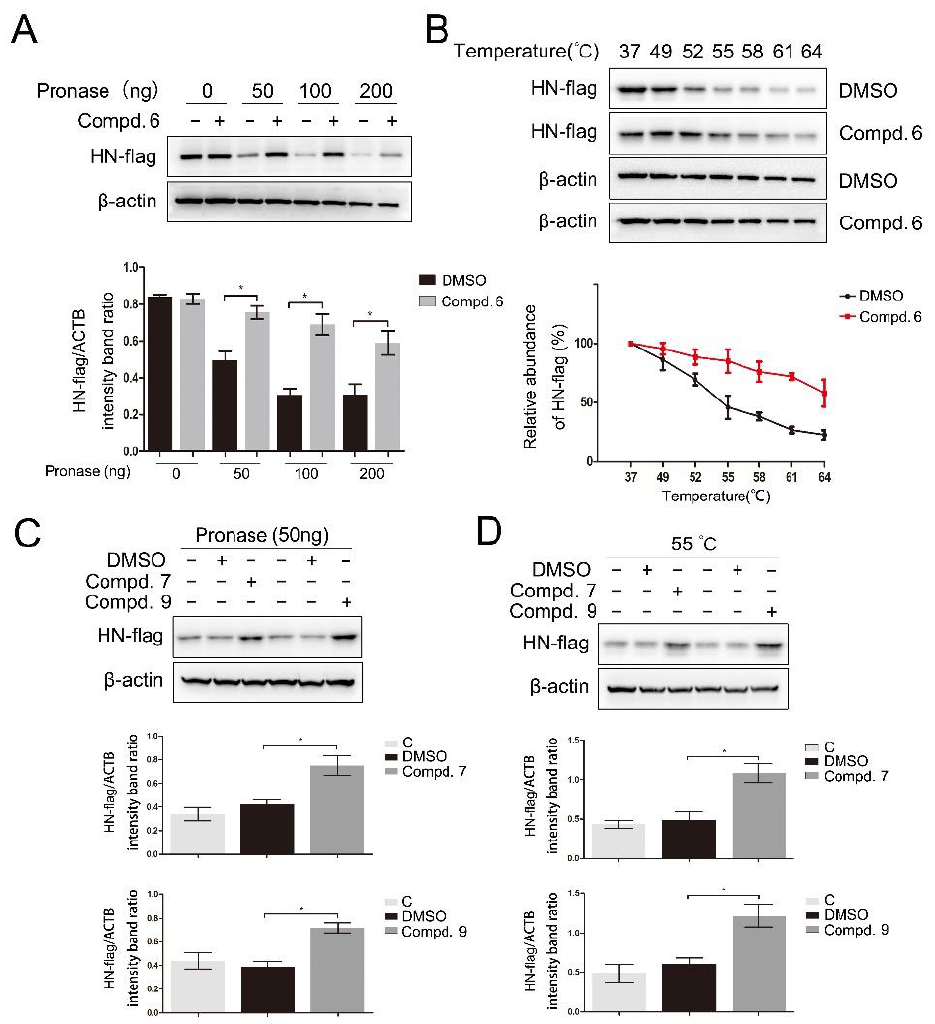
Figure 5. Direct binding of 1-formyl- β -carboline derivatives with the HN protein. DF-1 cells, transfected with the HN-flag, were lysed with M-PER lysis buffer and incubated with 1-formyl- β -carboline derivatives (200 µ M) or DMSO. ( A ) The cell lysates were treated with the indicated concentration of pronase and protein was measured by Western blot (up). The HN-flag protein levels relative to ACTB levels were determined by densitometry (down). ( B ) The cell lysates were heated at the indicated temperature and protein was measured by Western blot (up). The HN-flag protein levels relative to ACTB levels were determined by densitometry (down). ( C ) The cell lysates were treated with pronase (50 ng) and protein was measured by Western blot (up). The HN-flag protein levels relative to ACTB levels were determined by densitometry (down). ( D ) The cell lysates were heated at 55 ◦ C and protein was measured by Western blot (up). The HN-flag protein levels relative to ACTB levels were determined by densitometry (down). The data represent the mean ± SD of three independent experiments. The statistical significance was analyzed using a two-tailed Student’s t -test: * p < 0.05.